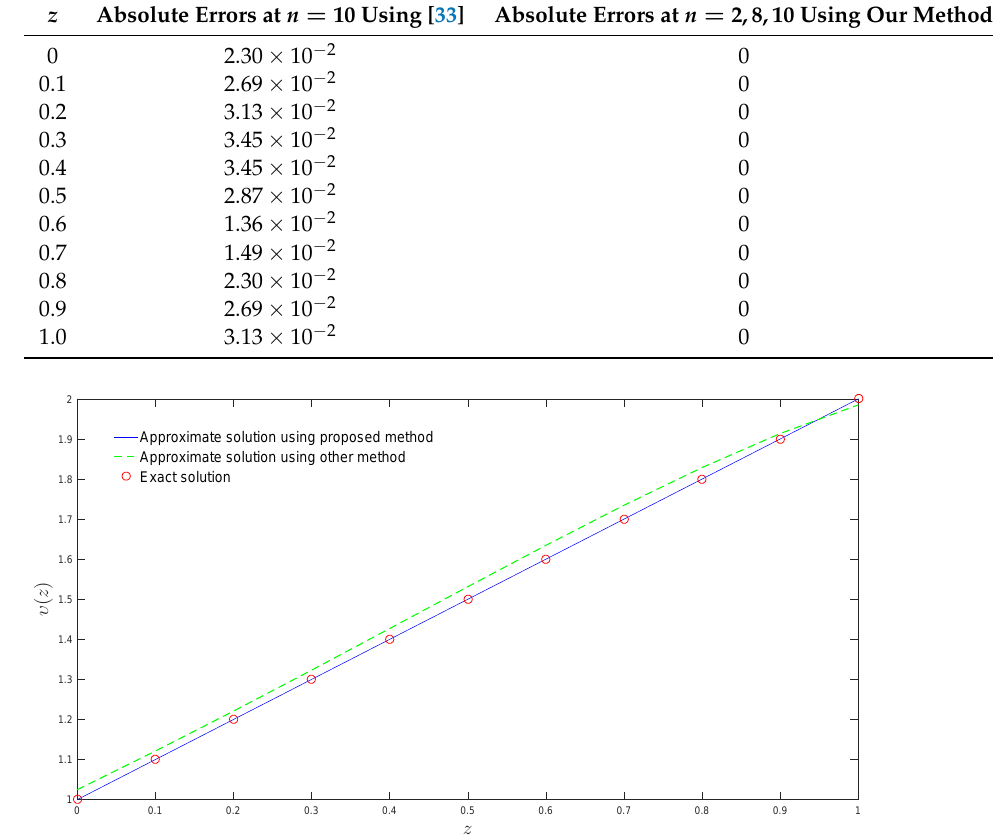
Table 2. Comparison of absolute errors of Example 1.